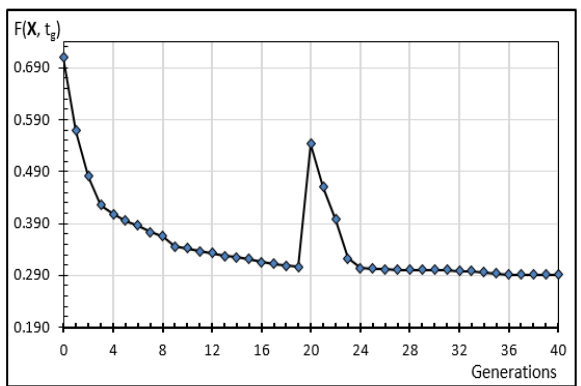
Figure 6. Average fitness function of the population over the generations.